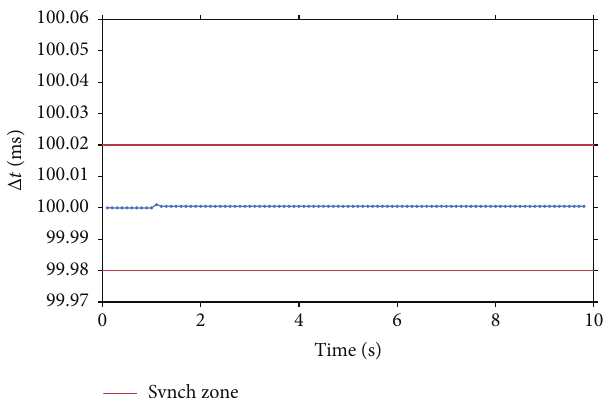
Figure 12: Interarrival times of sync messages to the slave. Linearly increasing delay.